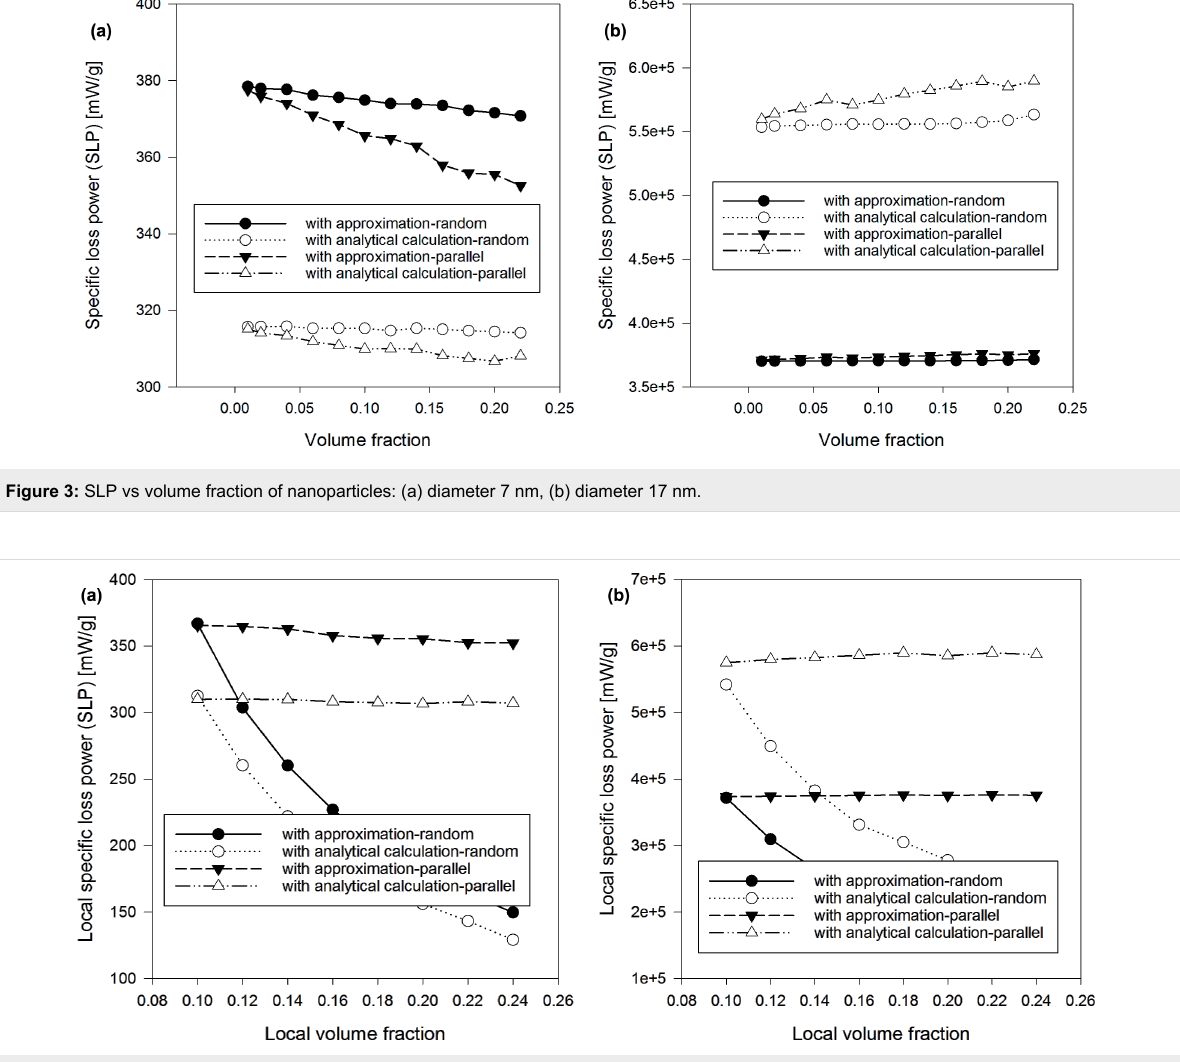
Figure 4: SLP vs local volume fraction in clusters of nanoparticles: (a) diameter 7 nm, (b) diameter 17